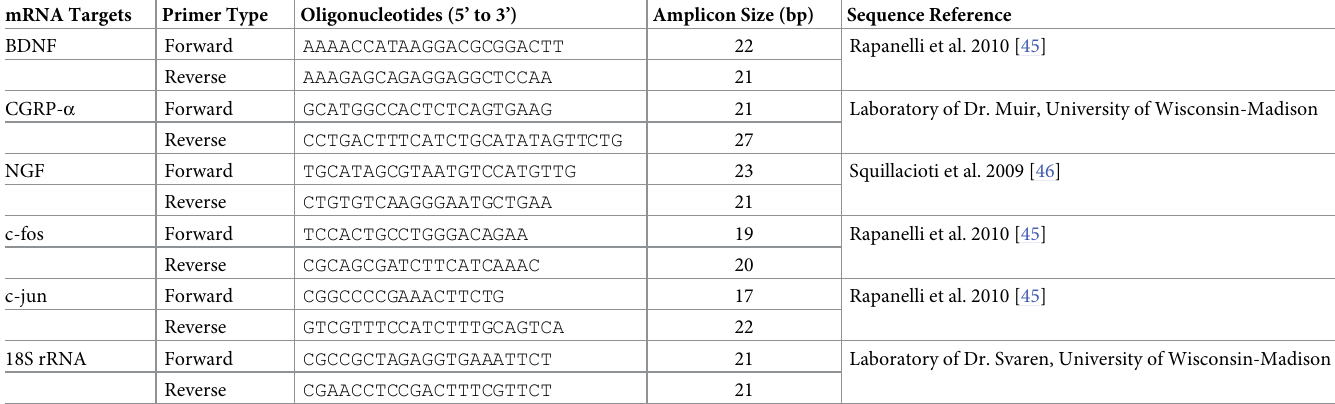
Table 1. Oligonucleotide primers for quantitative real-time reverse-transcriptase-polymerase chain reaction. mRNA